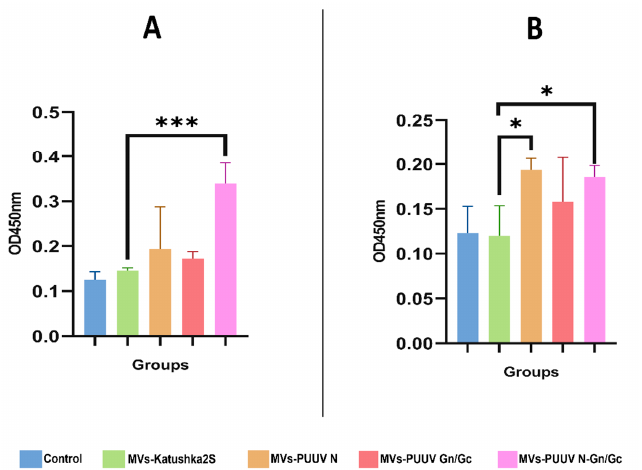
Figure 8. Serum anti-orthohantavirus IgG in mice treated with MVs carrying PUUV N, Gn/Gc as well as their combination. Serum samples were collected 14 and 28 after injection of MVs expressing PUUV N, Gn/Gc and combination of these proteins. Serum samples from the mice treated with 0.9% NaCl solution as well as from mice treated with MVs-Katushka2S were used as control. Anti- orthohantavirus proteins antibodies were detected using ELISA. ( A )—anti-orthohantavirus antibody level at 14 days after MVs treatment; ( B )—anti-orthohantavirus antibody level at 28 days after MVs treatment. Results are presented as OD 450 values. Data is represented as median Pharmaceutics 2022 , 14 , x FOR PEER REVIEW ** p < 0.01, *** p < 0.005. p value < 0.05 was considered statistically significant.